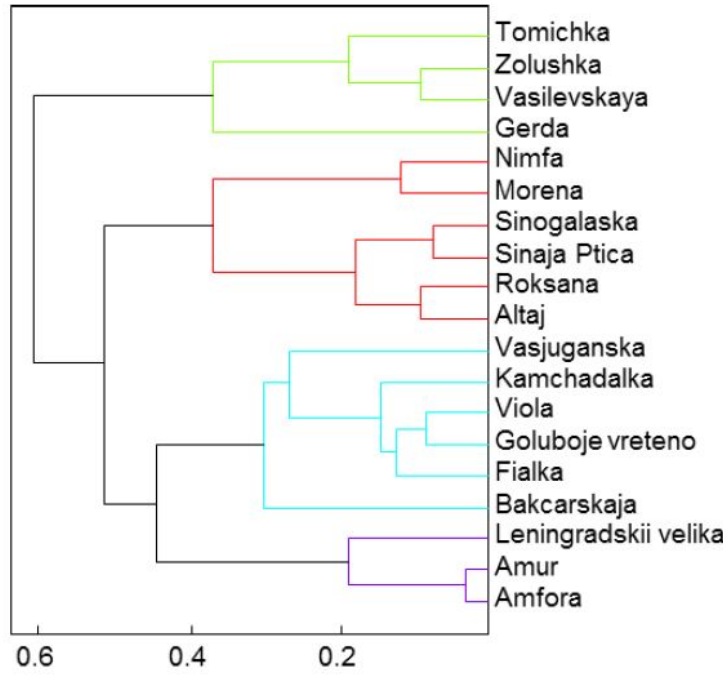
Figure 2. The cluster analysis of mineral elements represented by four principal